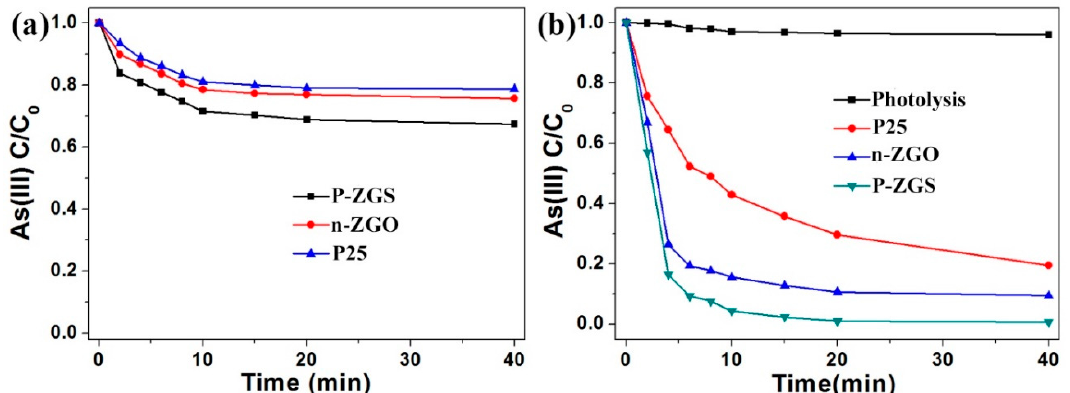
Figure 7. The temporal changes in the concentration of As(III) with various photocatalysts under different experimental conditions: ( a ) in the dark and ( b ) with UV-254nm